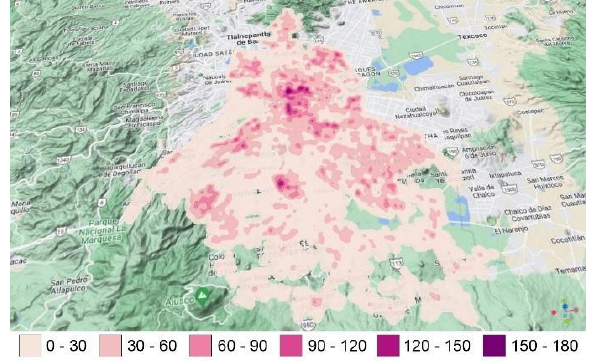
Figure 4. Gender crime heatmap of Mexico